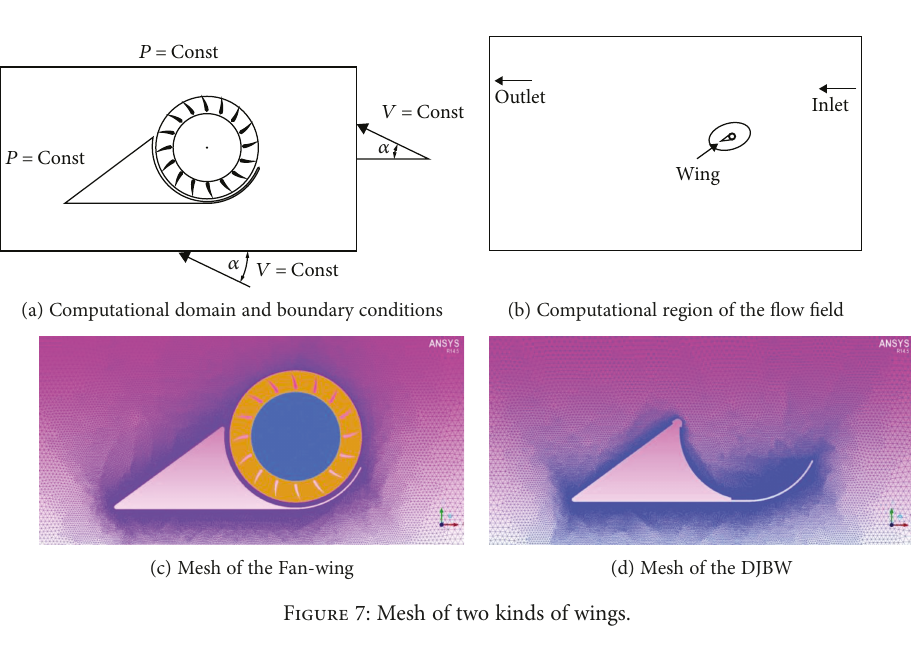
Figure 7: Mesh of two kinds of wings.